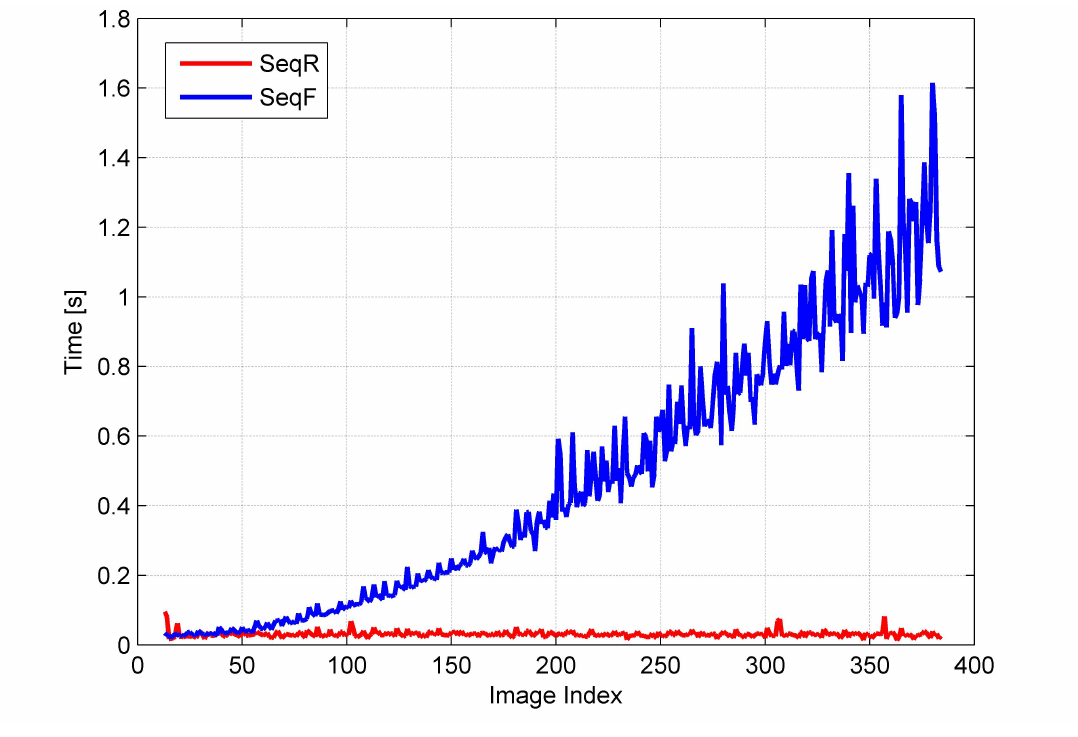
Figure 10. Processing time of the three AT methods (zoomed in).